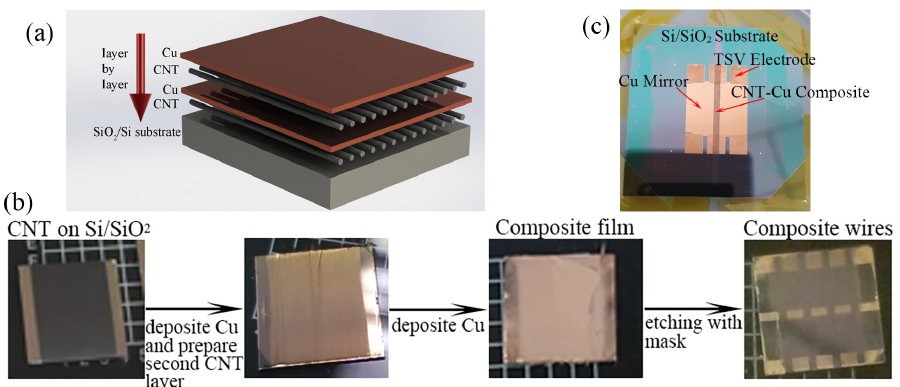
Figure 1. ( a ) Schematic diagram of the CNT-Cu composite preparation process; ( b ) technological process; ( c ) The photo of the ultimate atom chip with CNT–Cu wires.